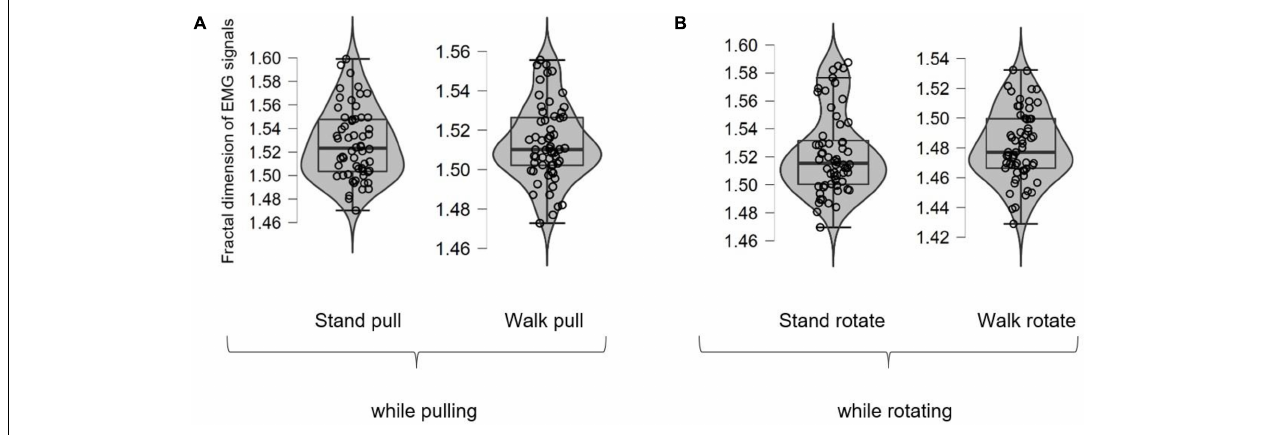
FIGURE 5 | The box plots for the fractal exponent of EMG signals in walking and standing while pulling (A) and rotating (B) .